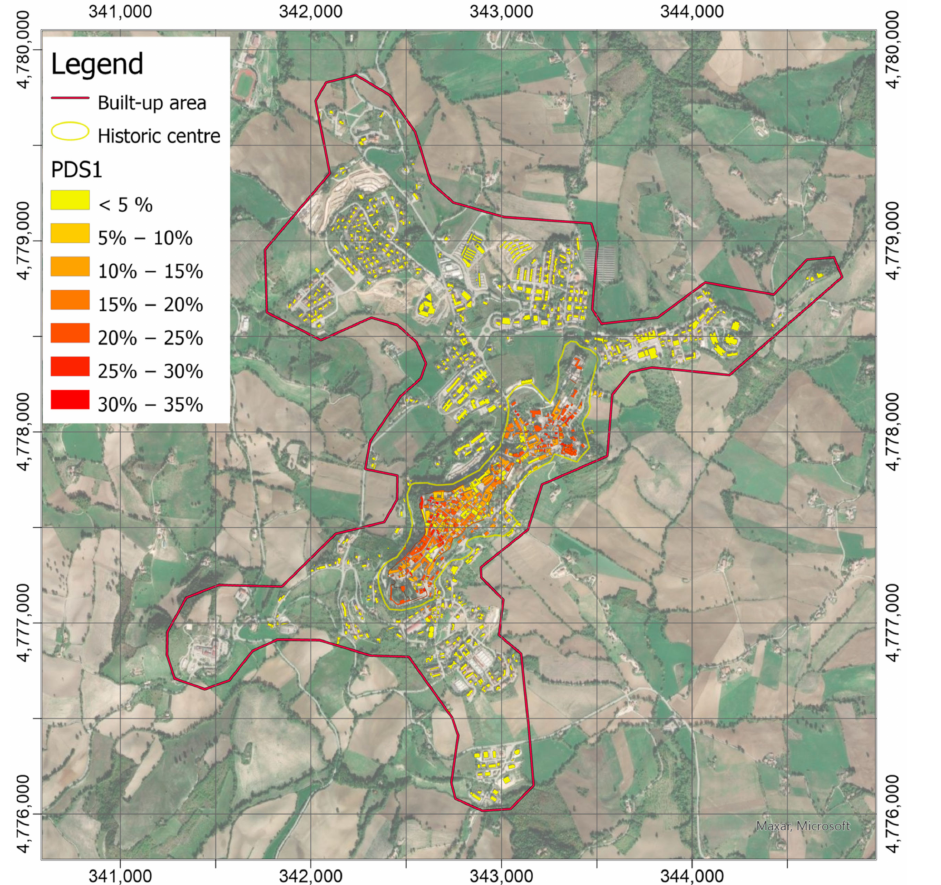
Figure 12. Probabilities map to reach or exceed the DS1 damage levels of the EMS-98 scale. The map is obtained by means of Equation (1) with parameters θ DS 1 and β in Table 1 according to building classification in Figure 11 and accelerations in Figure